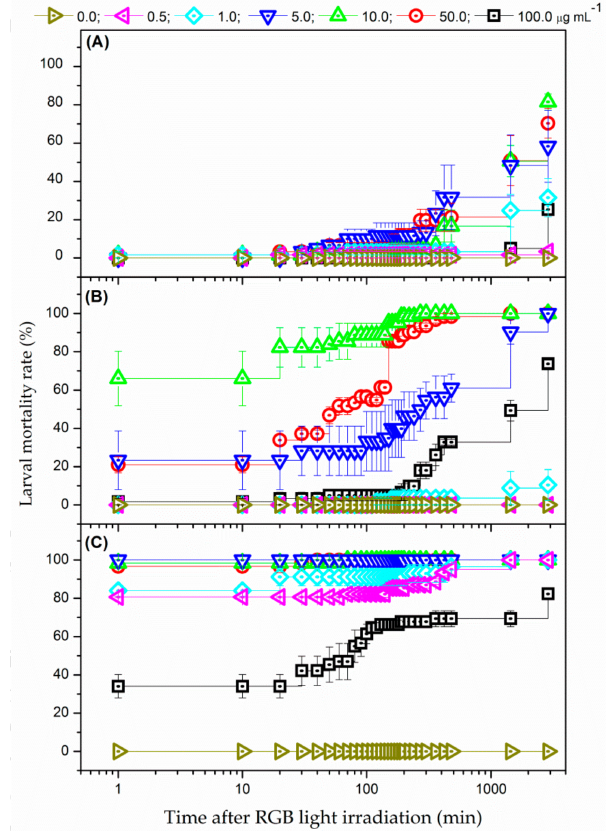
Figure 3. Larval mortality rate as a function of time after white-light irradiation from RGB LEDs at 27 mW/cm 2 during: ( A ) 15, ( B ) 30, and ( C ) 60 min, for different EMB concentrations: ( δ ) 0.0, ( Ψ ) 0.5, (N) 1.0, ( ∆ ) 5.0, (9) 10.0, (.) 50.0, and (#) 100.0 µ g mL − 1 . Error bars represent